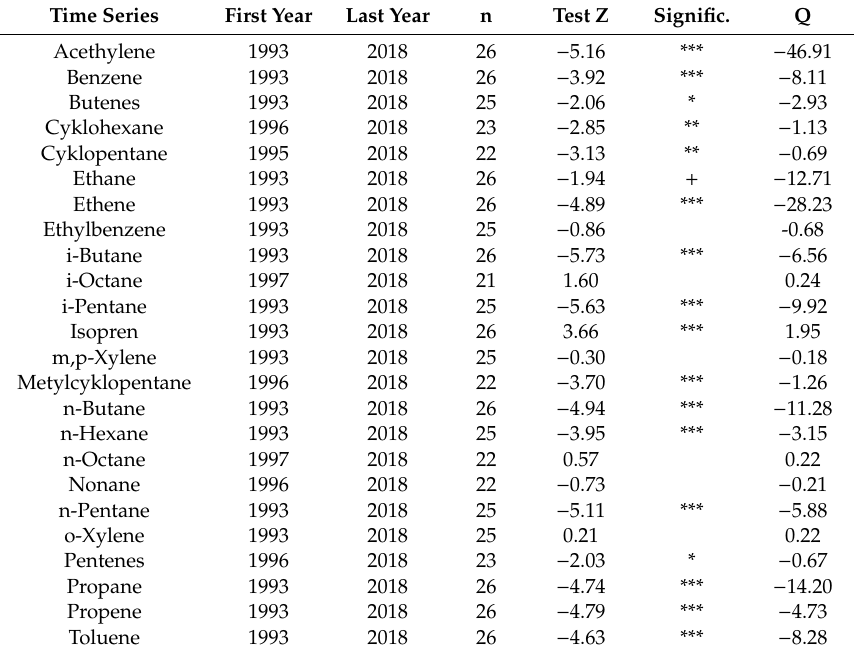
Table 2. Trend significance of measured VOCs.